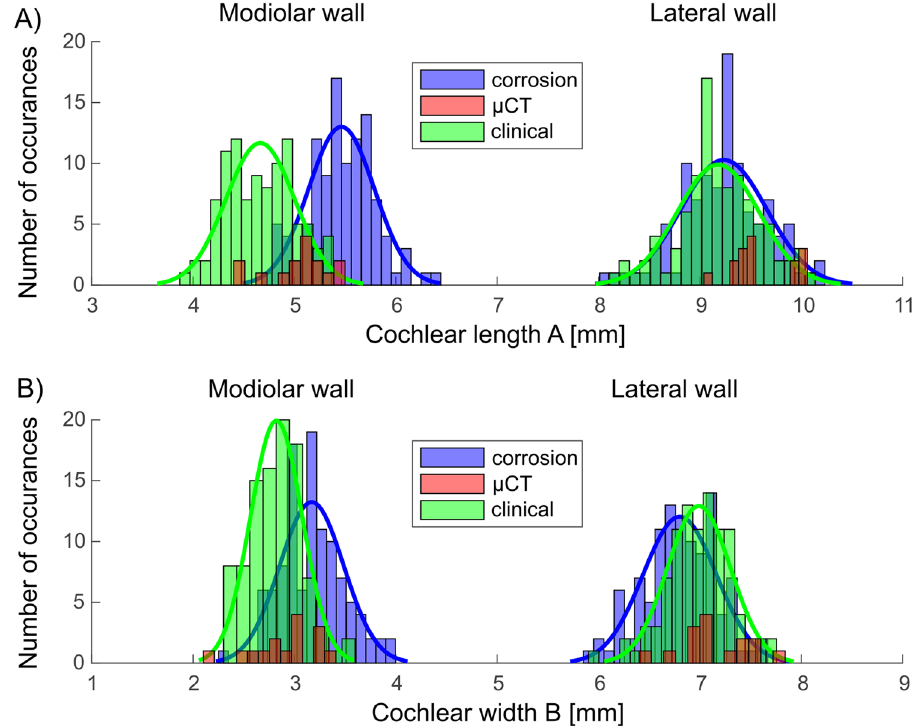
Figure 3. Variability of ( A,B ) measures of the lateral wall and modiolar wall in the three datasets